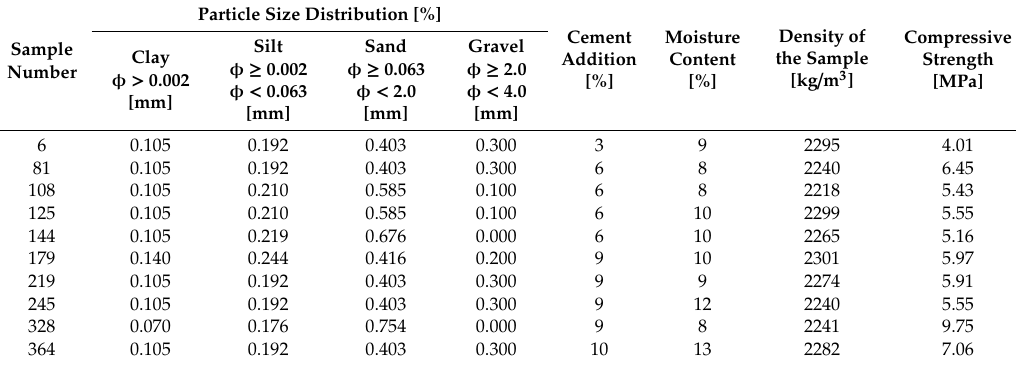
Table 2. Results of compressive strength for some chosen samples.